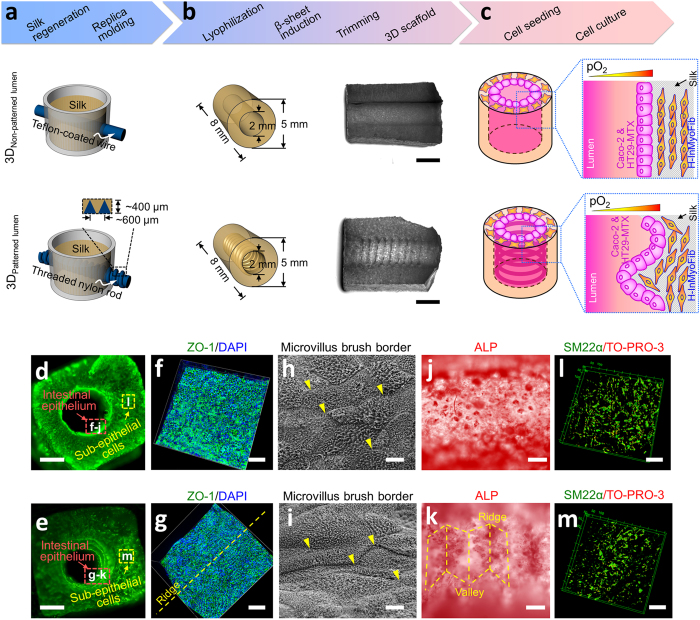
Human intestines on 3D porous silk scaffolds.(a,b) Schematics of the fabrication process for building silk-based porous scaffolds for 3D human intestine engineering. Silk scaffolds with hollow channels were prepared using a sequential six step process involving silk regeneration, cylindrical PDMS mold casting, insertion of Teflon-coated wires or Nylon screw across the cylinder, application of the silk solution, lyophilization and β-sheet induction. Upon completion of this process, the Teflon-coated wires or Nylon screw was removed, leaving a 3D, porous scaffold with a 2 mm diameter of non-patterned or screw-patterned (patterned, ridge like features with a height of 400 μm) hollow channels spanning the length of the scaffold and a bulk space that contained interconnected pores surrounding the channel. The scaffolds were then reproducibly trimmed along the axis of the hollow channels into 5 mm diameter × 8 mm long (mm) cylinders (b, Scale bars, 4 mm). (c) Schematics show the 3D non-patterned and patterned intestine system layout. (d,e) F-actin stain of 3D scaffolds without patterns (upper panel) and with patterns (lower panel) demonstrates how intestinal epithelial cells and myofiblasts localize in the 3D silk scaffolds. Scale bar, 1 mm. (f–k) 3D confocal images of ZO-1 immunostaining, SEM, and ALP staining on the epithelial cells seeded in the scaffold lumens demonstrated fully polarized epithelial cells. Scale bars, 100 μm (f,g), 1 μm (h,i), 200 μm (j,k). (l,m) 3D confocal view of immunostaining of SM22α on cells seeded in the bulk space (week 8) showed H-InMyoFibs keep their phenotype on the scaffolds. Scale bar, 50 μm.